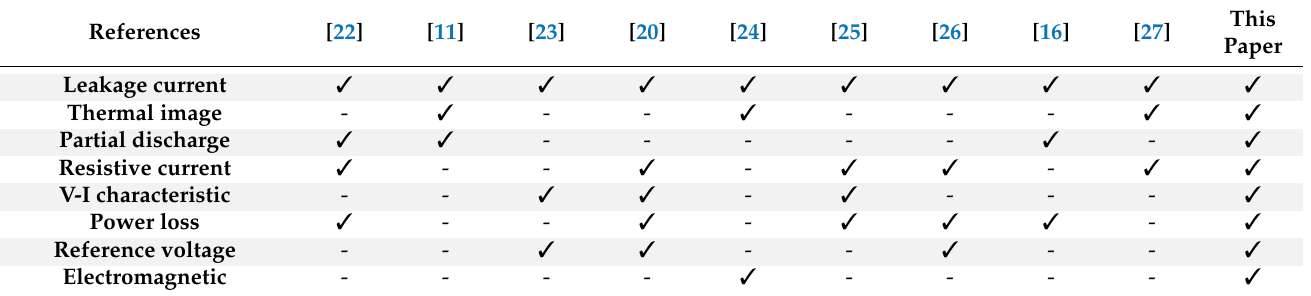
Table 1. Comparison of papers related to MOSA diagnostic and condition